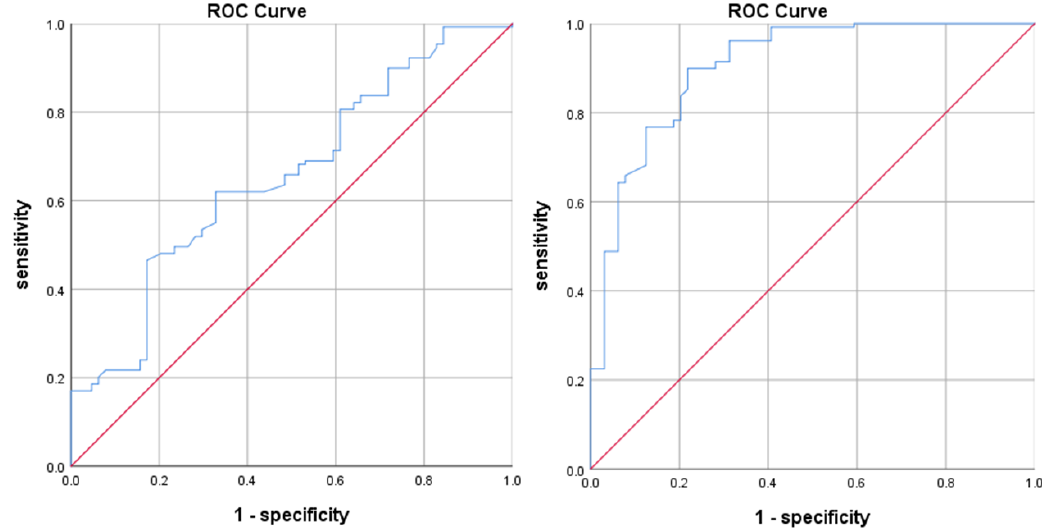
Figure 1. ROC curve for tumor volume ( left ) and EI ( right ).